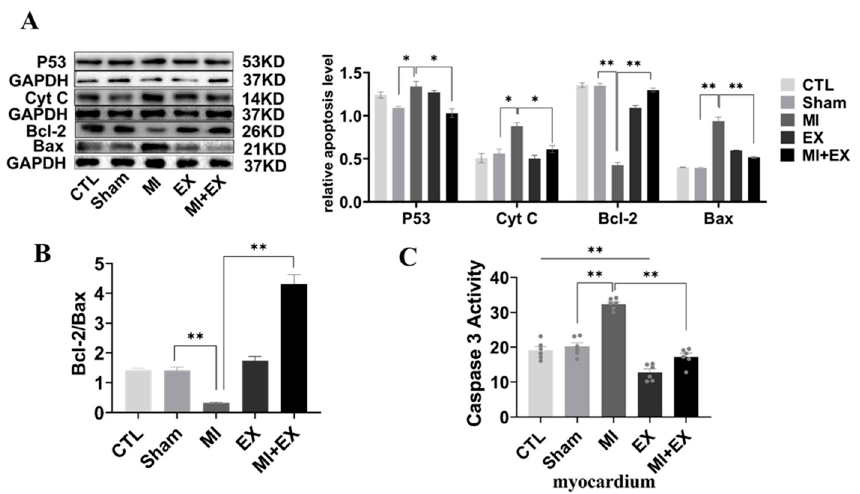
Figure 9. Effect of exercise and no exercise on cardiomyocyte apoptosis following MI. ( A ) Representative blots of the apoptotic proteins, p53, Cyt C, Bcl-2, and Bax, in tissue ( n = 3). ( B ) Bcl-2/BAX ratio. ( C ) The activity of caspase 3 in the myocardium was measured using a spectrophotometer ( n = 6). The values are presented as the mean ± SEM. CTL, normal control; MI, myocardial infarct; EX, CTL + exercise; MI + EX, MI+ exercise. * p < 0.05, ** p < 0.01.